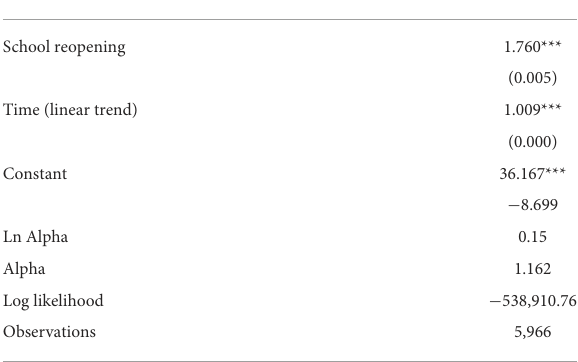
TABLE 1 Random effects Poisson regressions with entity-specific intercepts (ACs).